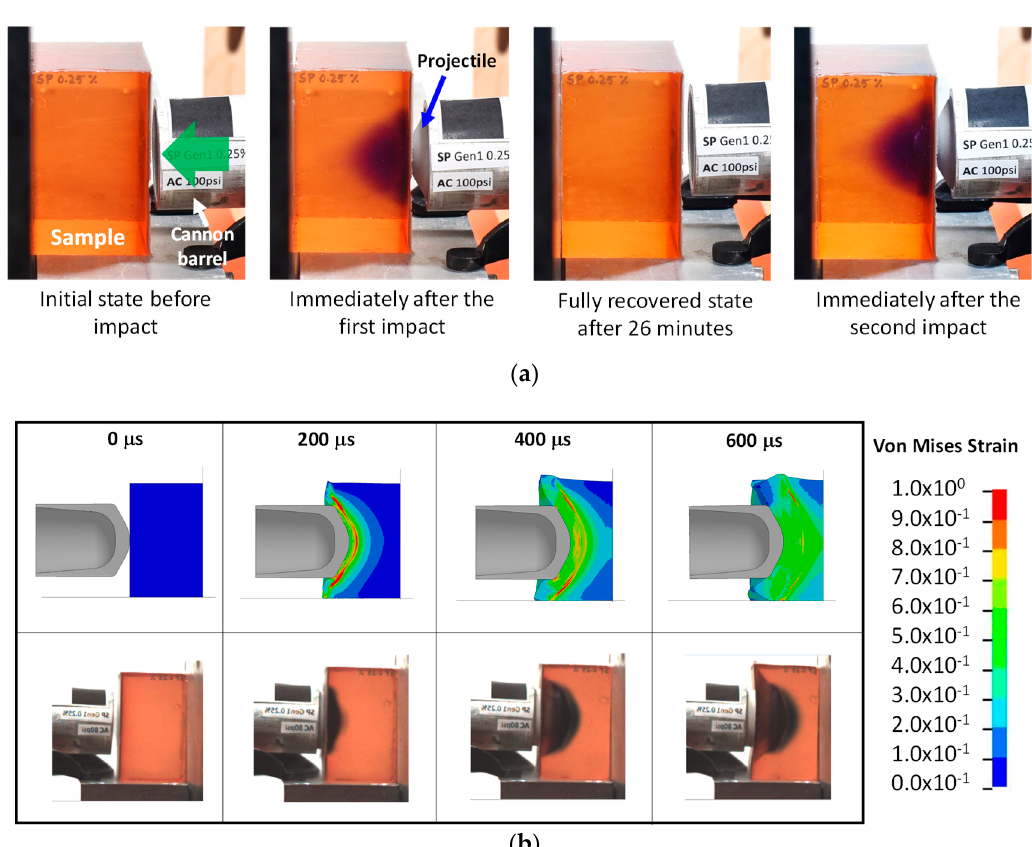
Figure 5. ( a ) Color change in SP-PDMS during and after impact at an impact speed of 100 m/s. The arrow shows the projectile impact direction. ( b ) Von Mises strain contours during the impact process via (top row) and high-speed video (bottom row). The PDMS (poly(dimethyl siloxane)) had a mixing ratio of 10:1 with 0.25% SP (spiropyran).